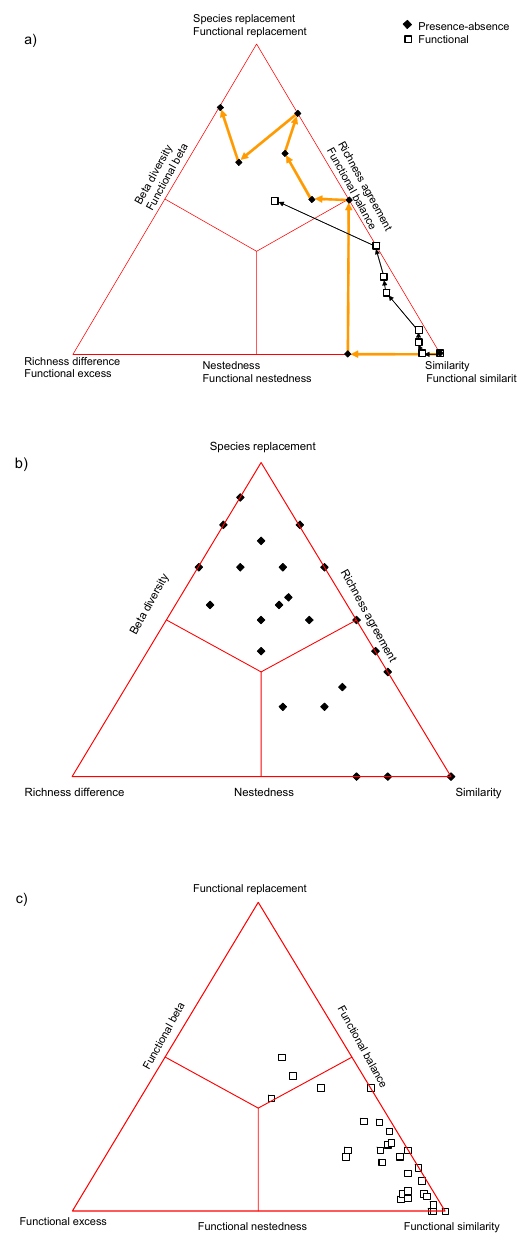
Figure 1. Analysis of the sample data. ( a ) A SDR simplex plot for the decomposition of the generalized Jaccard index for functional components. The two trajectories reflect the comparison of the first site with itself and all other sites along the sequence (see text), ( b ) taxon- (species-) based simplex plot, ( c ) functional simplex. Note that points corresponding to different plot pairs may coincide if they are identical in species composition, such as the endpoints of the two trajectories in ( a ) (pertaining to plot pairs 1–8 and